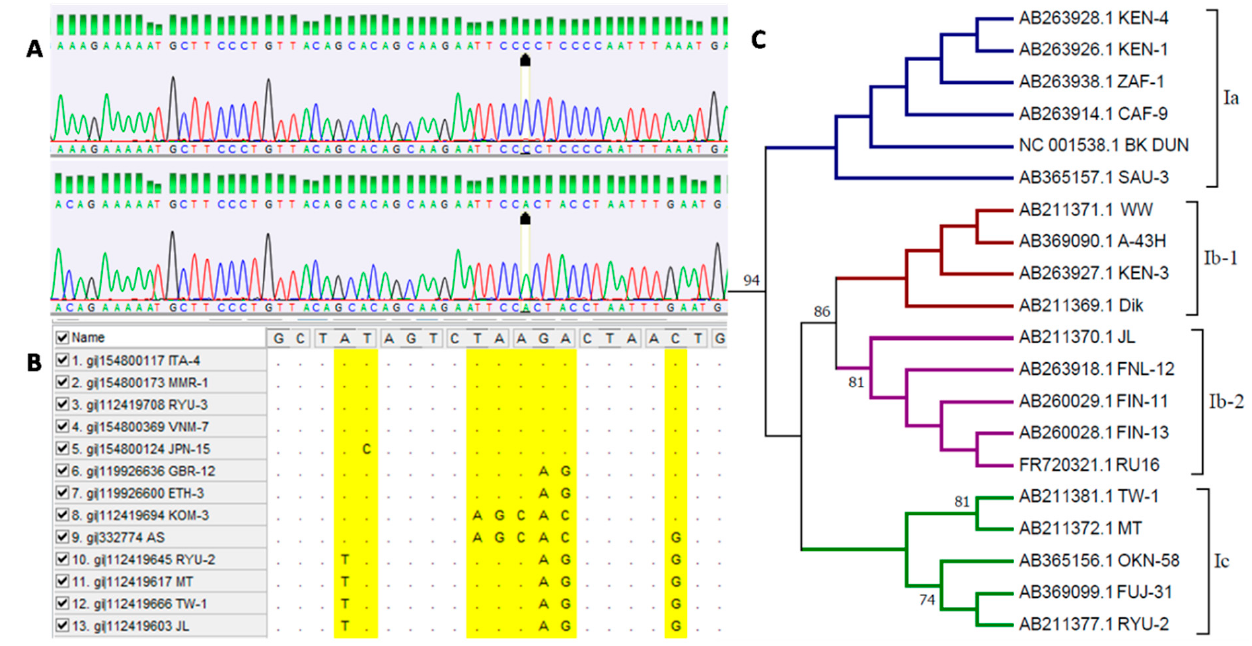
Figure 2. Bioinformatic analysis of BK polyomavirus sequences including ( A ) analysis of chromatograms representing sequences belonging to BKPyV genotypes I and IV (analysis performed in DNA Baser software), ( B ) preparation of sequence alignment from databases representing different virus genotypes, ( C ) analysis of phylogenetic relationships between virus subtypes within genotype I (analysis performed in MEGA 6 software). Own results.